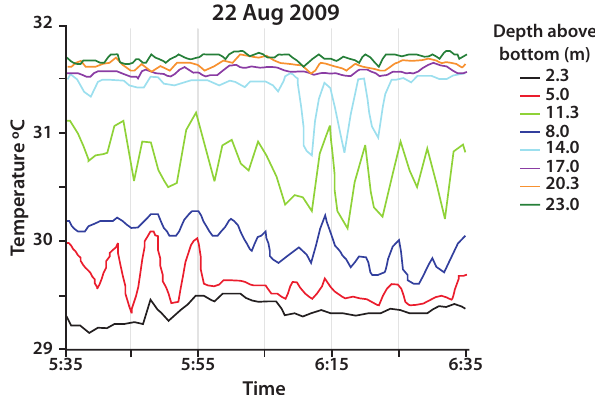
Fig. 6. Temperature measurements for 22 August 2009 near Abu Madafi (22 ◦ 04.509 0 N, 38 ◦ 46.181 0 E) using moored temperature loggers at 2.3, 5, 8, 11.3, 14, 17, 20.3 and 23m above bottom (bot- tom depth ≈